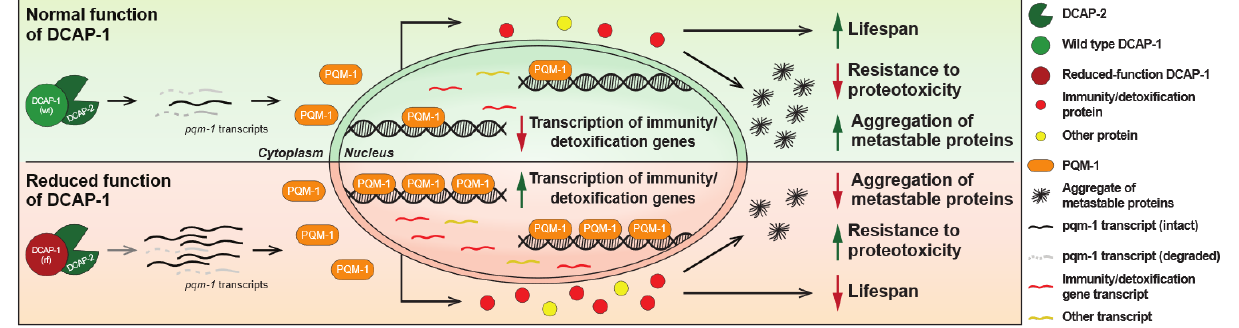
Figure 6. Proposed model for DCAP-1-mediated regulation of longevity and resistance to proteotoxicity via PQM-1 activity. Reduced function of DCAP-1 selectively stabilizes pqm-1 mRNA transcripts, resulting in increased PQM-1 expression and its translocation to the nucleus, where it induces the expression mainly of immunity/detoxification-related genes. The resulting accrual of the corresponding proteins has a negative impact on lifespan under normal conditions, but reduces the formation of protein aggregates and favors survival under extreme proteotoxic conditions, caused by metastable peptides.